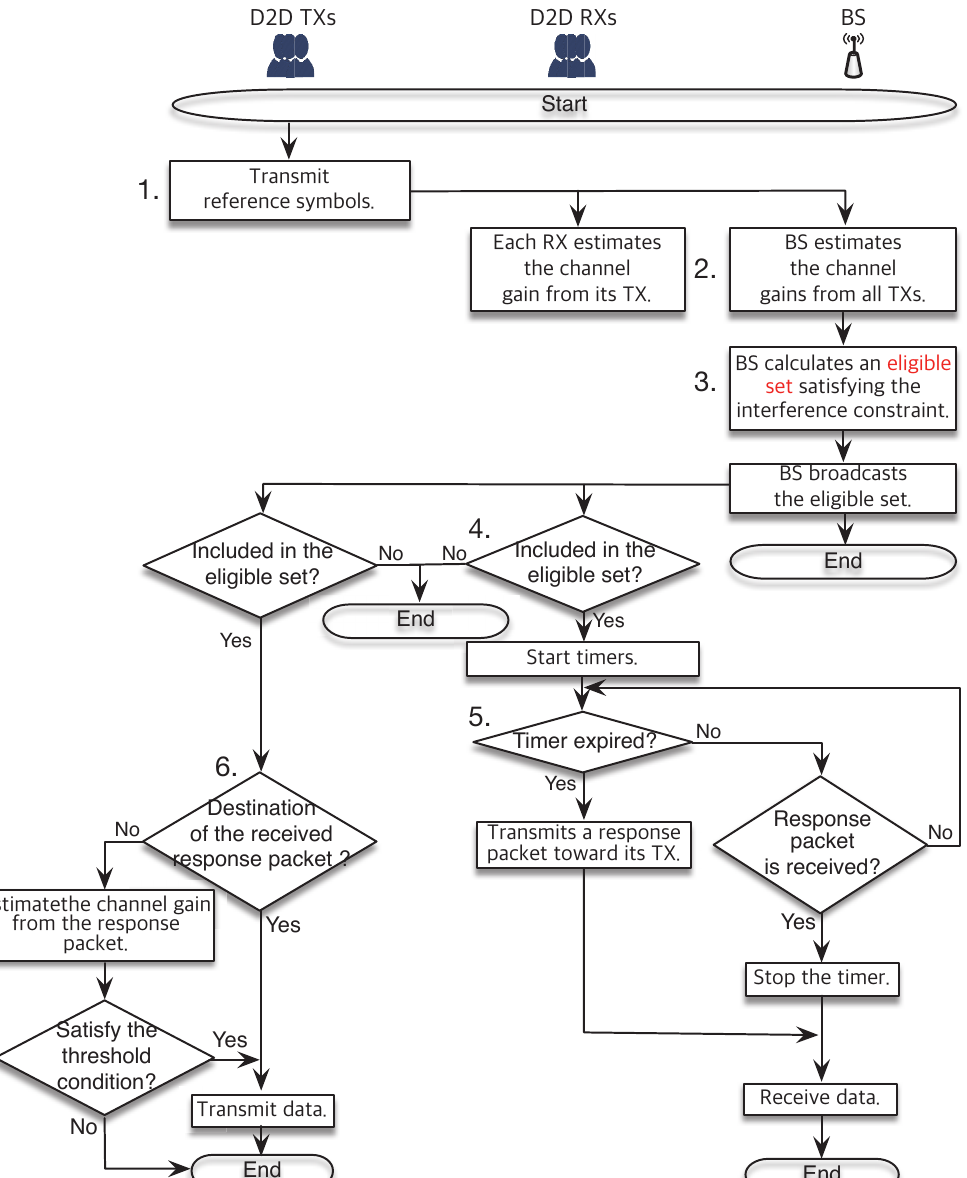
Figure 2. Flow diagram of the proposed scheme for cellular underlaid D2D communication networks.